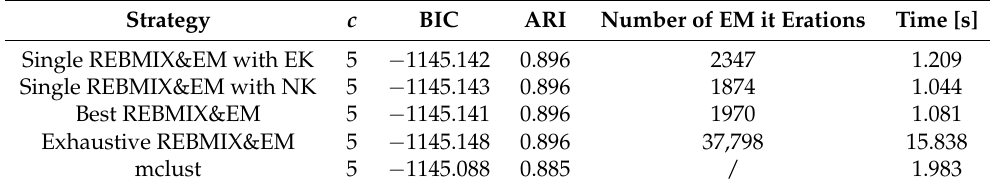
Table 3. Results on the dataset with a low level of overlap between the clusters.